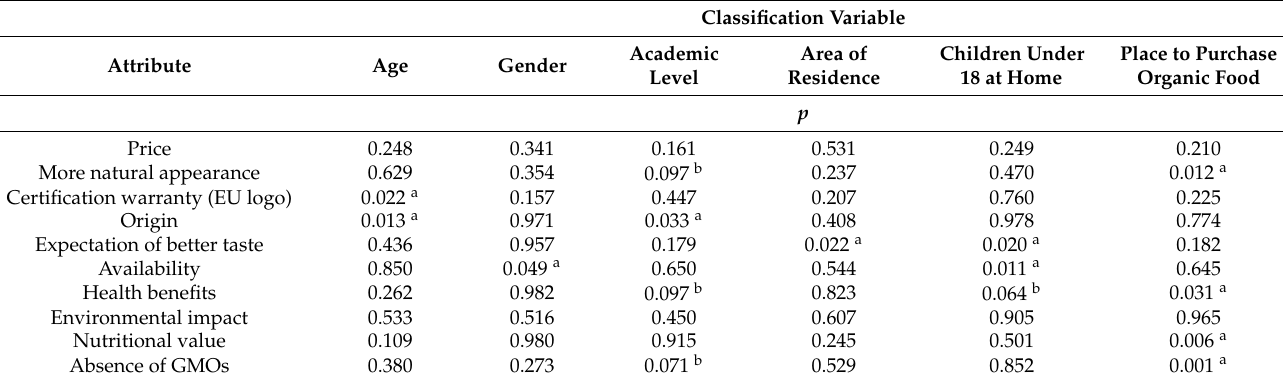
Table 4. Chi-square test for independence ( p